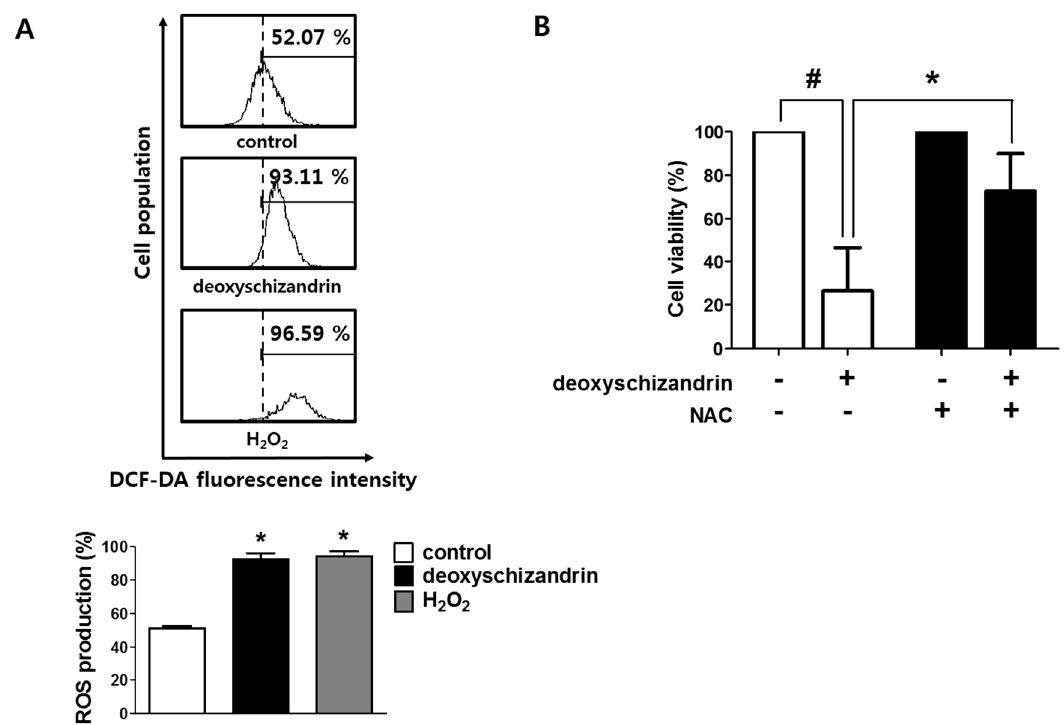
Figure 4. Involvement of intracellular ROS in deoxyschizandrin-induced cell cycle arrest in A2780 cells: ( A ) Generation of intracellular ROS was measured using DCFH-DA assay after deoxyschizandrin (30 µM) treatment for 30 min. The values represent the mean ± SD of results from three independent experiments. * p < 0.05 vs. the control group; ( B ) Involvement of intracellular ROS in deoxyschizandrin-induced cell cycle arrest in A2780 cells was examined using MTT assay. A2780 cells were treated with 5 mM of N -acetyl- L -cystein (NAC) and deoxyschizandrin (30 µM) for 48 h. NAC was used for ROS inhibition. The values represent the mean ± SD of results from three independent experiments. # p < 0.05 vs. the control group; * p < 0.05 vs. the treated group.